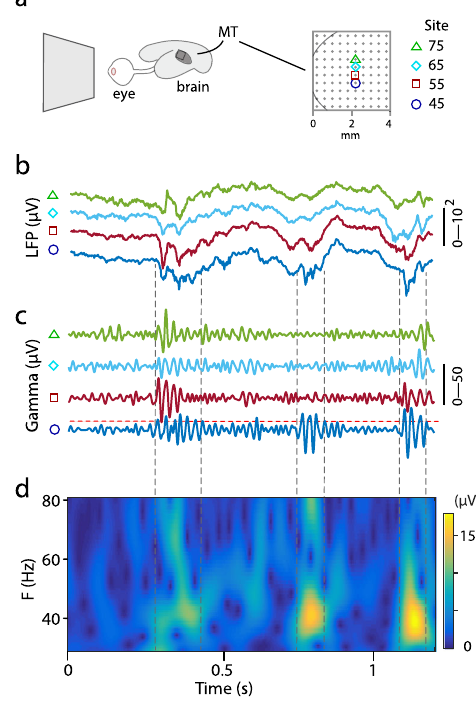
Fig. 2 Gamma bursts recorded from marmoset cerebral cortex. a Schematic representation of marmoset eye and brain showing approximate position of cortical area MT and the electrode array. Magni fi ed view of electrode array at right shows the estimated border of MT (thin gray curve) and electrode spacing. Four recording sites are indicated. b Broadband (0.1 – 500Hz) LFP signals at the four recording sites (case MA027). c 30 – 80Hz bandpass LFPs (gamma band) of the corresponding recording sites. Horizontal red dashed line represents power 2.5 s.d. above mean. d Time-frequency spectrogram of LFPs at recording site 45. Burst events are marked by gray vertical dashed